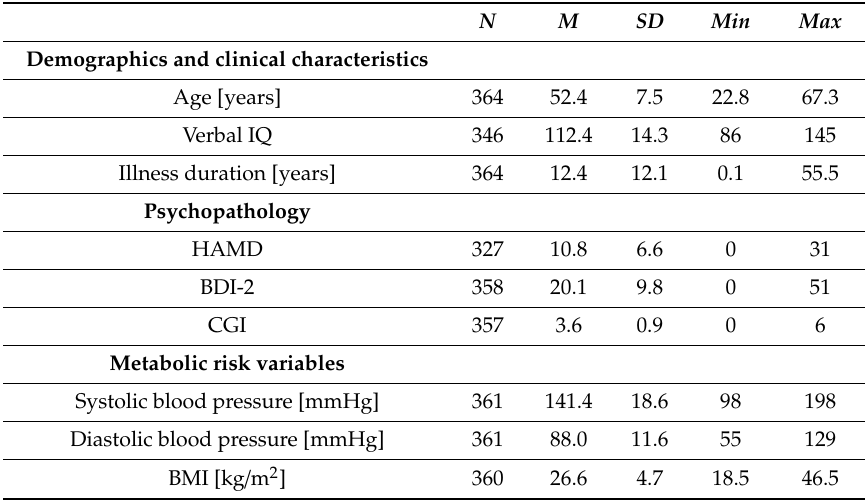
Table 1. Demographic, clinical, and biochemical characteristics (mean, standard deviations, minimum, maximum; N =